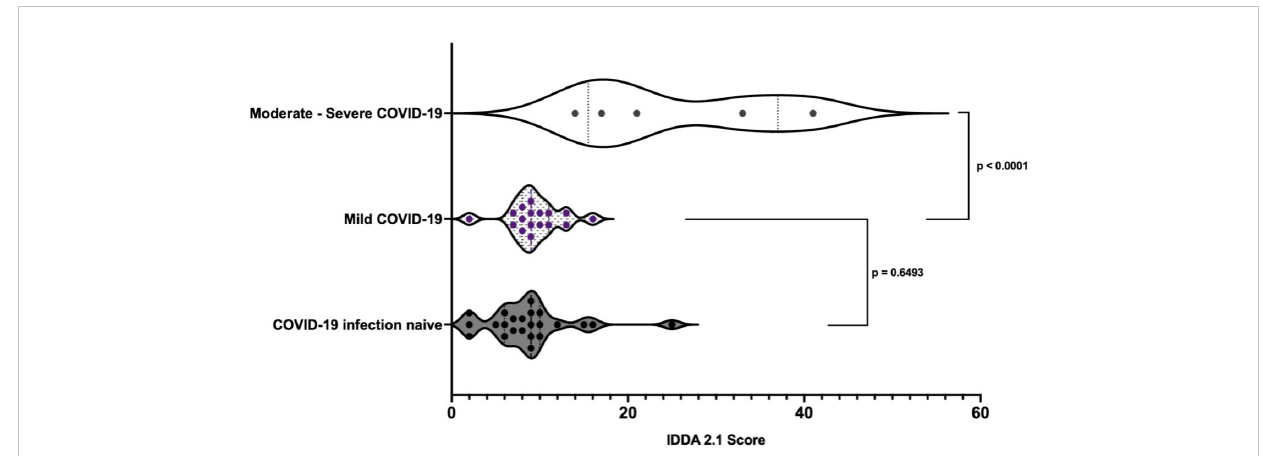
FIGURE 8 Pre-infection immune dysregulation and disease activity 2.1 scores in those individuals with IEI strati fi ed by COVID-19 disease severity.*Unpaired t